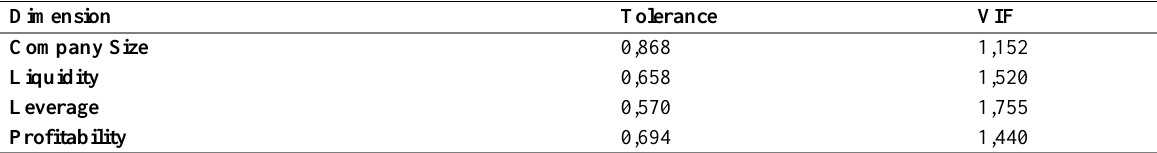
Table 3: Multicollinearity Test Results